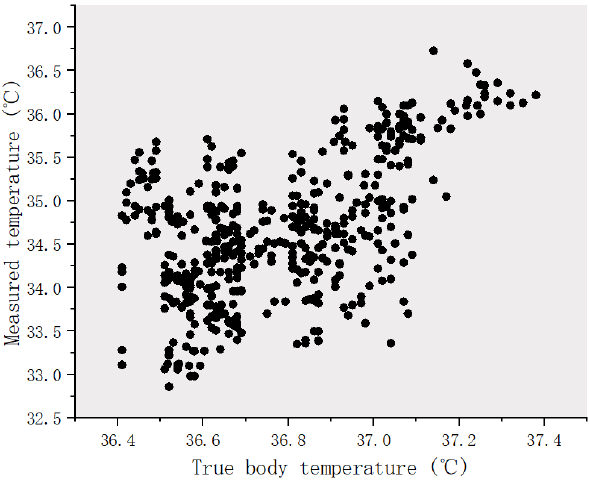
Figure 5. Scatter diagram of true body temperature and measured temperature.